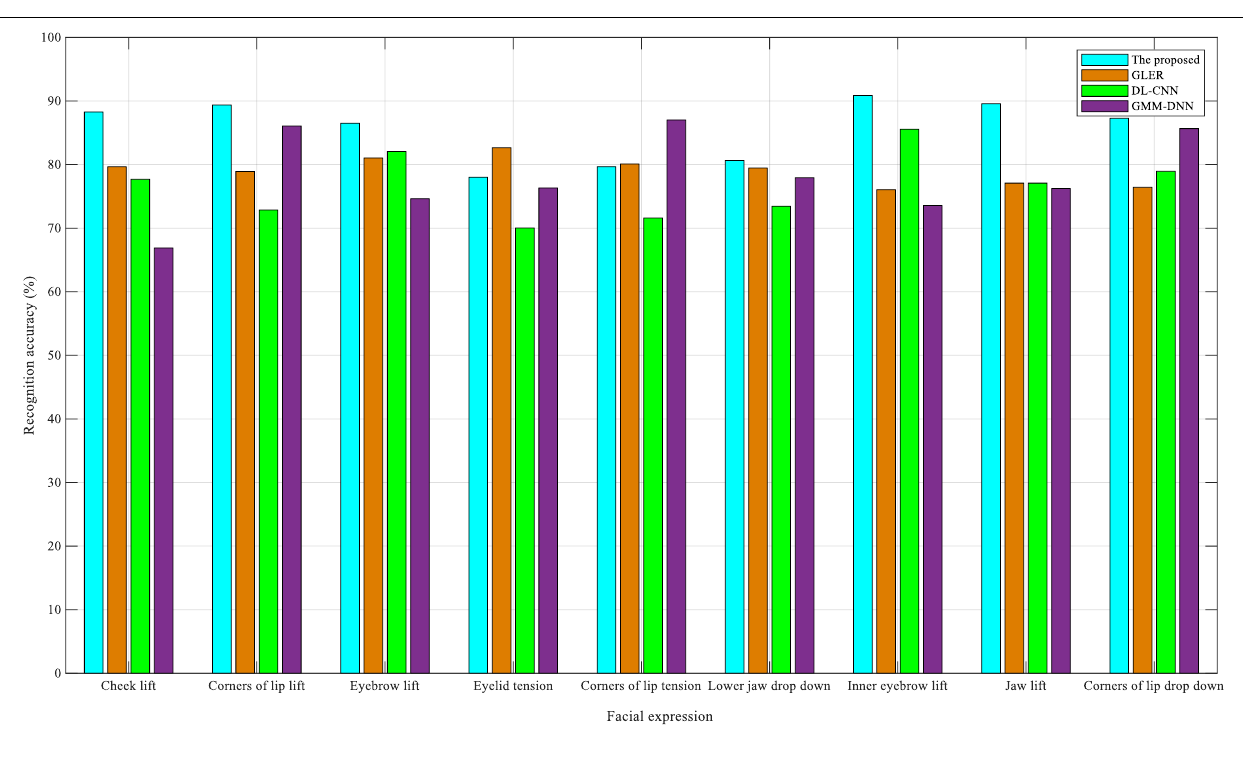
FIGURE 3 | Comparison of recognition accuracy in eNTERFACE05